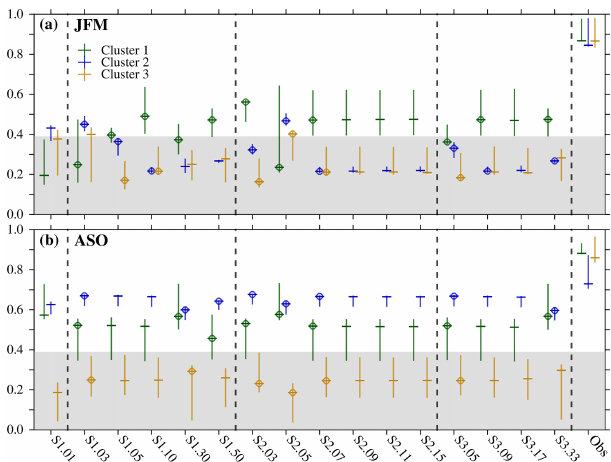
Figure 8. As in Fig. 7 but for clusters in Antarctica.